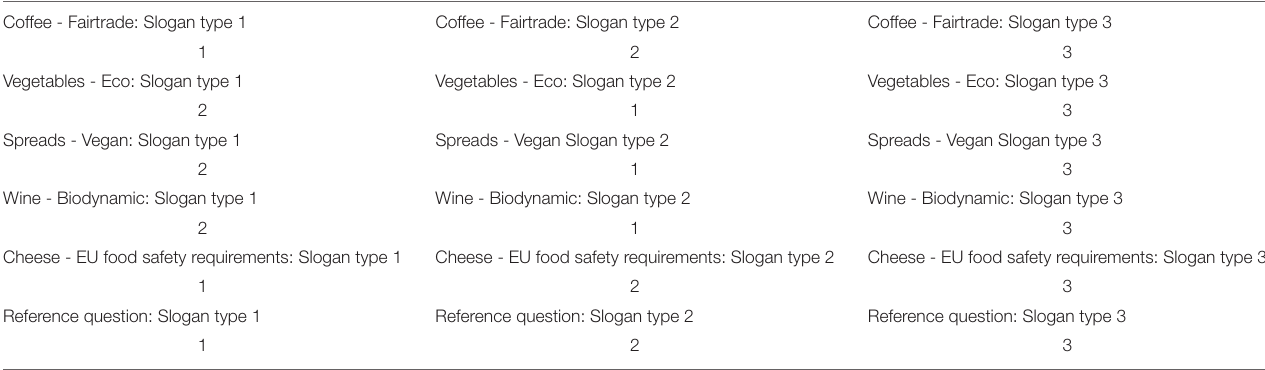
TABLE 2 | Ranking of individual types of slogans according to the quantitative expression of the number of respondents’ answers from the best (1) to the worlst (2); Source: own processing. Coffee - Fairtrade: Slogan type 1 Coffee - Fairtrade: Slogan type